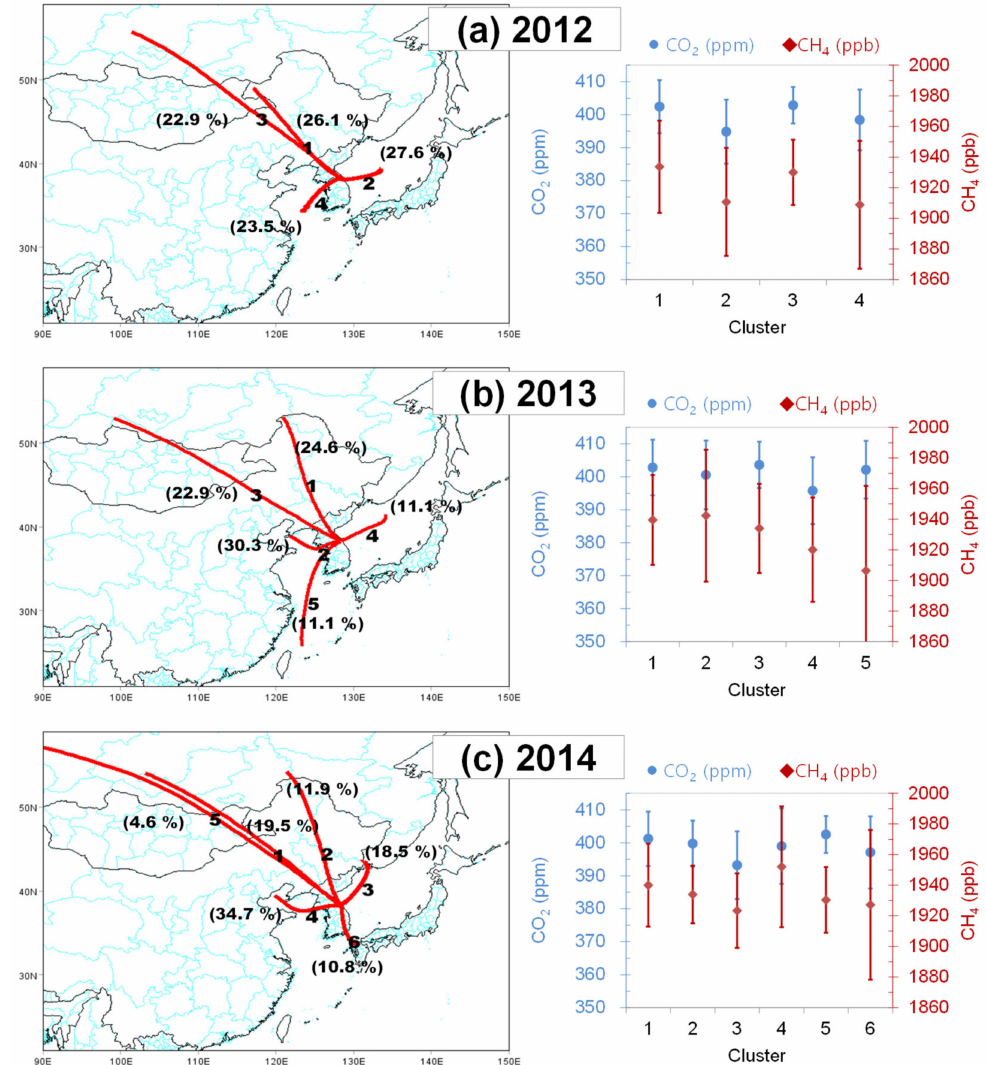
Figure A1. Annual mean trajectory clusters reaching the GS station (the left figures) and associated annual mean CO 2 and CH 4 concentrations (the right figures) for the year of ( a ) 2012, ( b ) 2013, and ( c ) 2014. In the map, each trajectory cluster is denoted by bold-face number and the percentage of air masses from each cluster is shown in